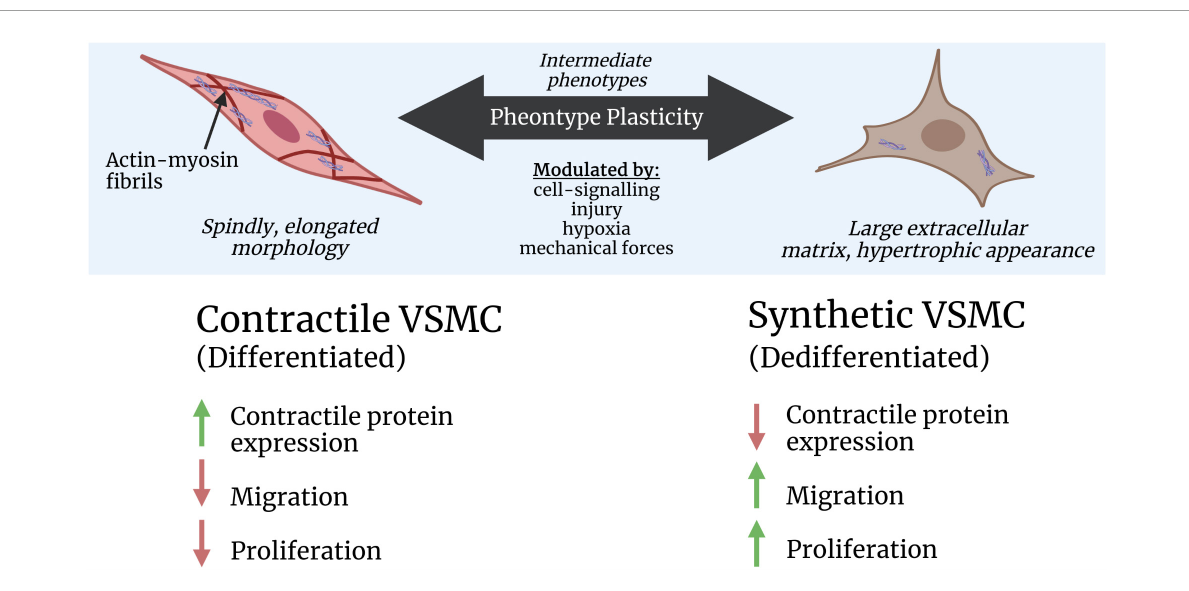
FIGURE2 Simplified illustration of contractile and synthetic vascular smooth muscle cell (VSMC) phenotype plasticity. The key attributes for each phenotype are presented relative to each other, including their expression of contractile protein genes, migration, and proliferation. Higher levels are indicated by green, upward-facing arrows, and lower levels are indicated by red, downward-facing arrows. This figure was created by GH rendering using